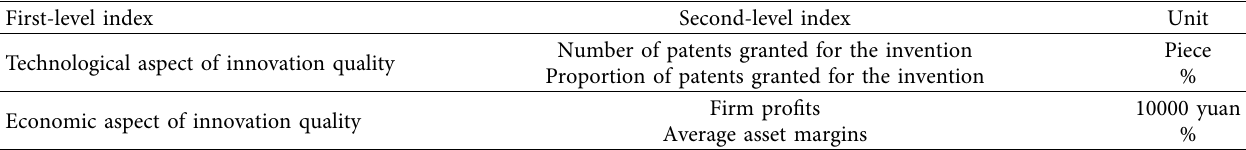
Table 1: Evaluation index system of regional innovation